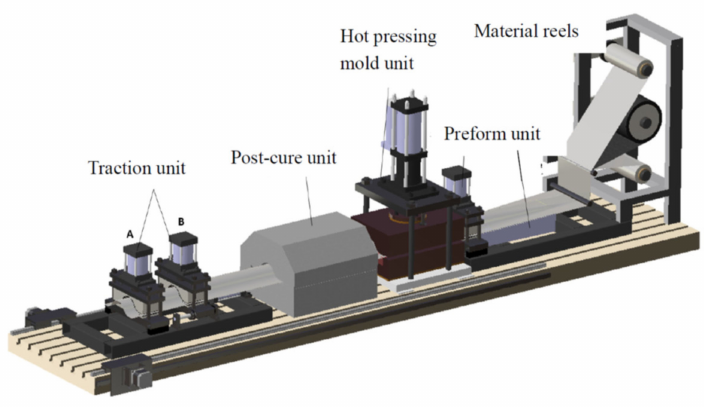
Figure 1. Manufacture process of the